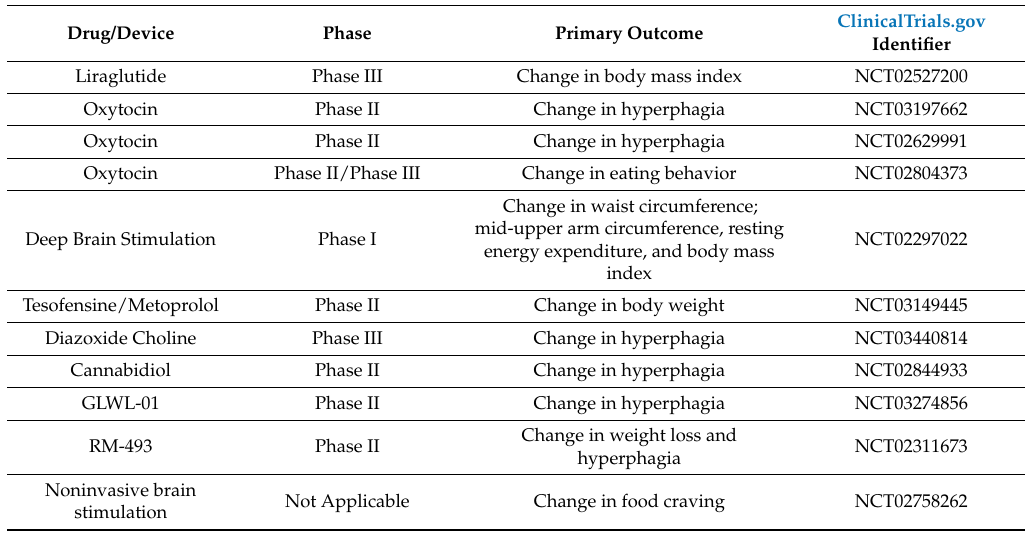
Table 1. Clinical trials currently recruiting patients or active, conducted in patients with Prader–Willi syndrome (PWS), posted on clinicaltrials.gov (last verified May